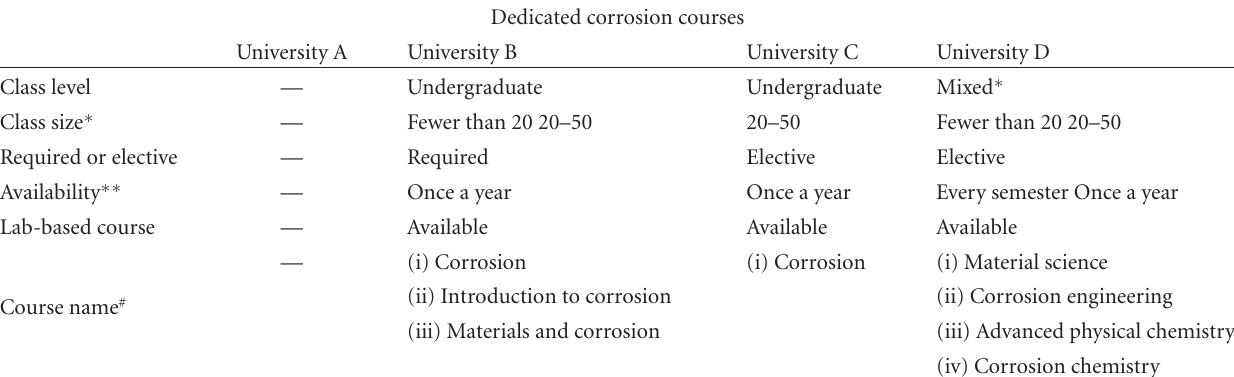
Table 4: Details on dedicated corrosion courses.